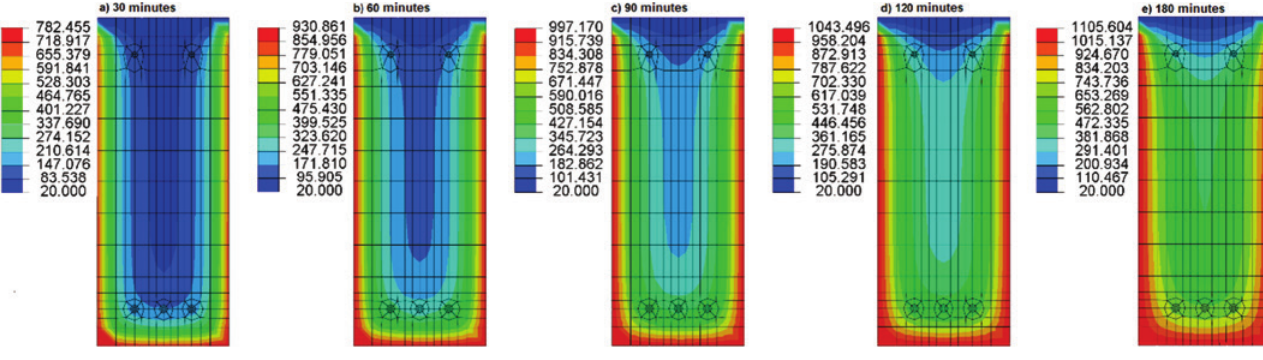
Figure 6 Isotherm B1-IV for ratings of (a) 30, (b) 60, (c) 90, (d) 120, and (e) 180 minutes